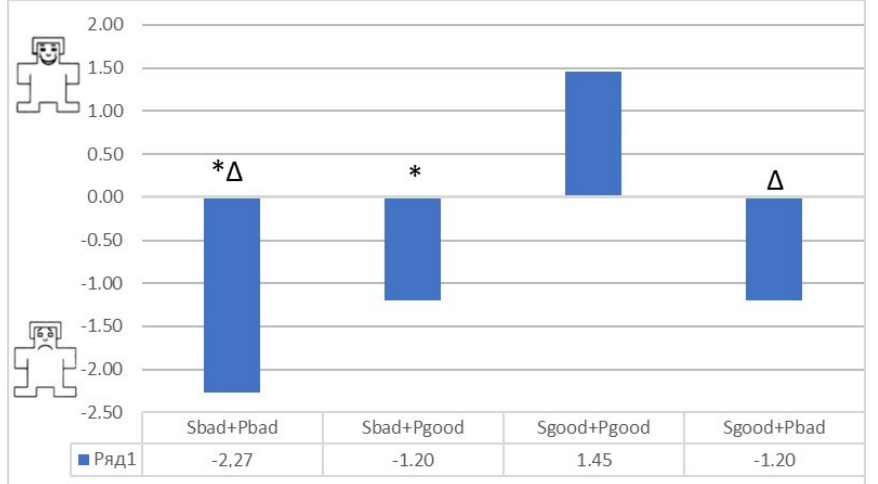
Figure 10. Comparison of the mean values of the stimuli valence in the Basic and Dissonance complexes. Special symbols indicate significant differences in valence according to the Wilcoxon signed − rank test: * − signi fi cant di ff erences ( p < 0.05) between the valence values associated with the